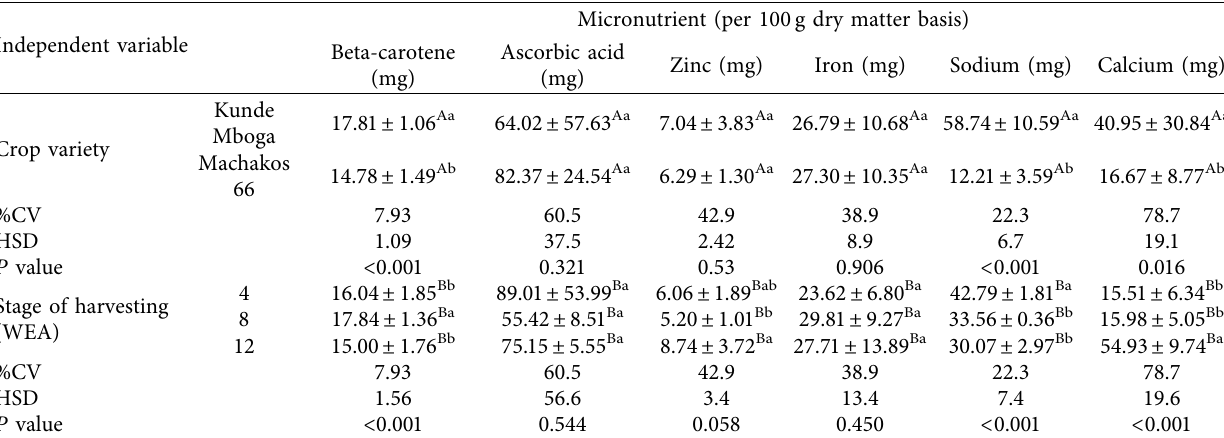
Table 8: Main efect crop variety and stage of harvesting on the micronutrient content of cowpea leaves.